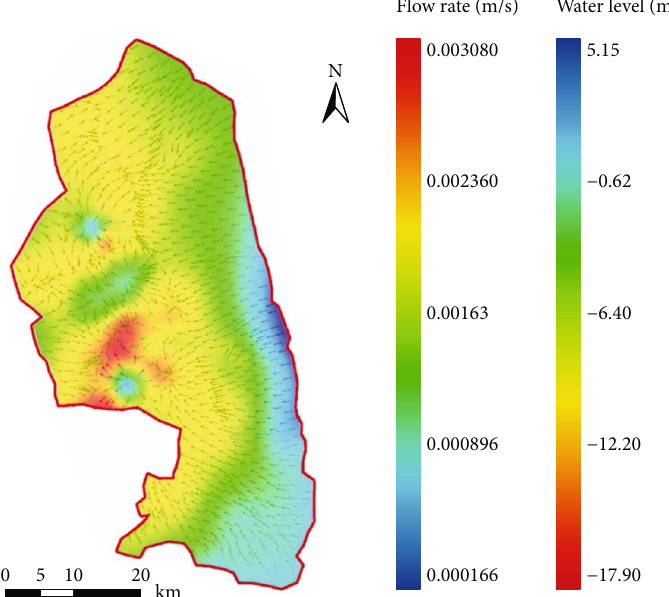
Figure 7: The visualization results of porous groundwater seepage fl ow fi eld based on point plot method.